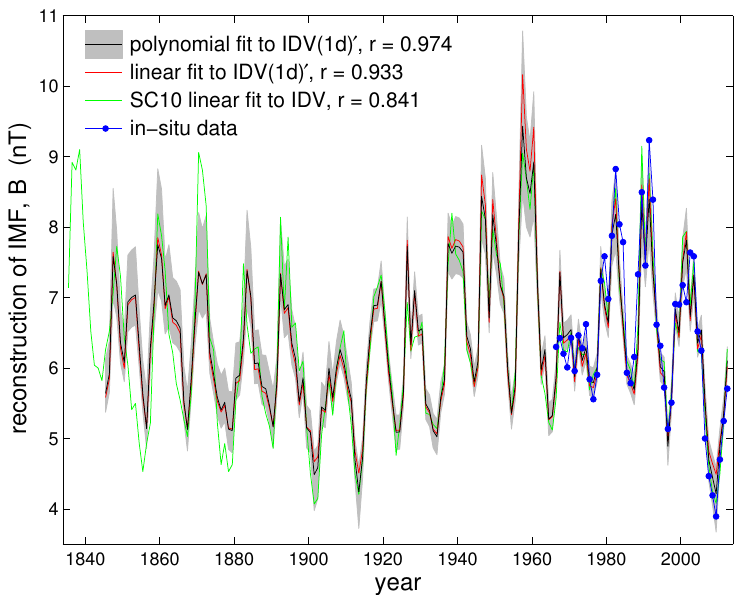
Figure 33: Reconstructions of the near-Earth IMF, 𝐵 , from geomagnetic data with uncertainty analysis. The black line uses the new geomagnetic activity composite, 𝐼𝐷𝑉 (1 𝑑 ) (Lockwood et al. , 2013a) and the polynomial fit to 𝐵 . The grey area surrounding this black line is the uncertainty band associated with using this polynomial fit derived using a Monte-Carlo technique (see Figure 32 and text for details) and also includes the uncertainty caused by the inter-calibration of the 𝐼𝐷𝑉 (1 𝑑 ) stations. The red line shows the best reconstruction using a linear fit. The green line shows the reconstruction of Svalgaard and Cliver (2010). Blue dots show the annual means of the observed IMF (from Lockwood et al. ,